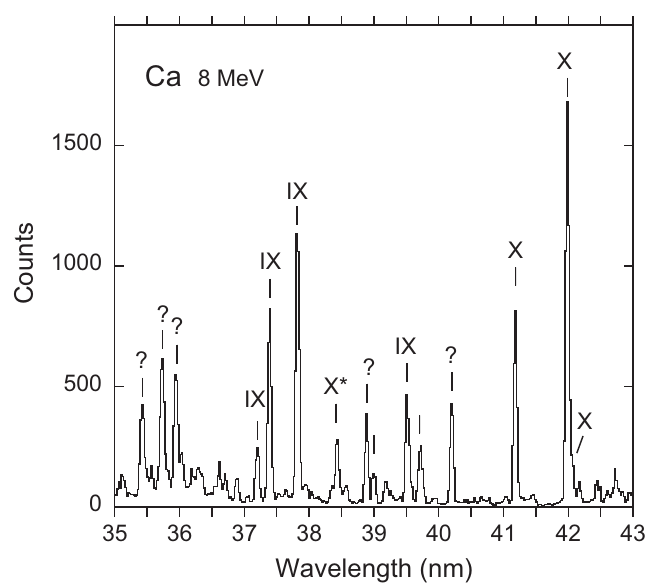
Figure 2. Beam-foil spectrum of 40 Ca recorded at an ion beam energy of 8MeV, slightly lower than the optimum ion beam energy for the production of the CaX spectrum [74]: Spectra taken at 11MeV are very close to this one in appearance. Line width (FWHM) is 0.06nm. The more prominent ones among the lines are labeled by the spectrum number [75]. A number of lines remains unidentified, owing to the spectrum analysis that for Ca is much less complete than for other elements. The CaX* line of interest (near λ = 38.5nm) is accompanied by unidentified other lines, but the wavelength determination is hardly affected.